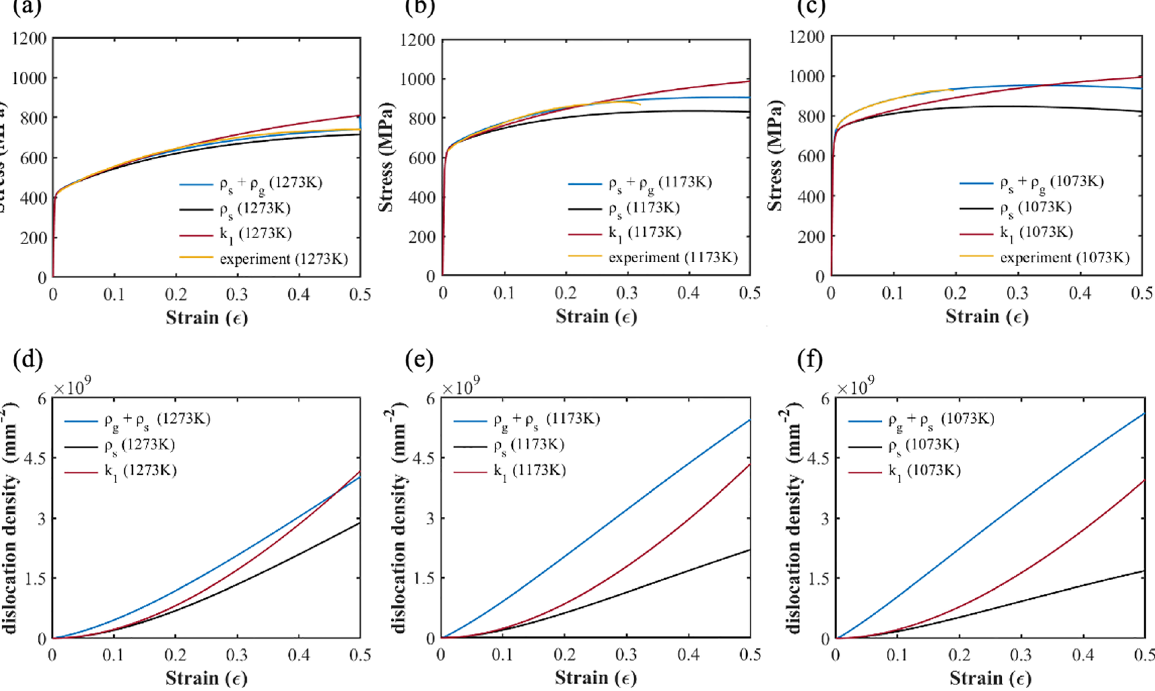
Figure 6. The stress–strain curves and total dislocation density evolution curves for the three hardening rules for the three annealing temperatures: ( a ) Stress–strain curve at 1273 K; ( b ) stress–strain curve at 1173 K; ( c ) stress–strain curve at 1073 K; ( d ) total dislocation density evolution curve at 1273 K; ( e ) total dislocation density evolution curve at 1173 K; and ( f ) total dislocation density evolution curve at 1073